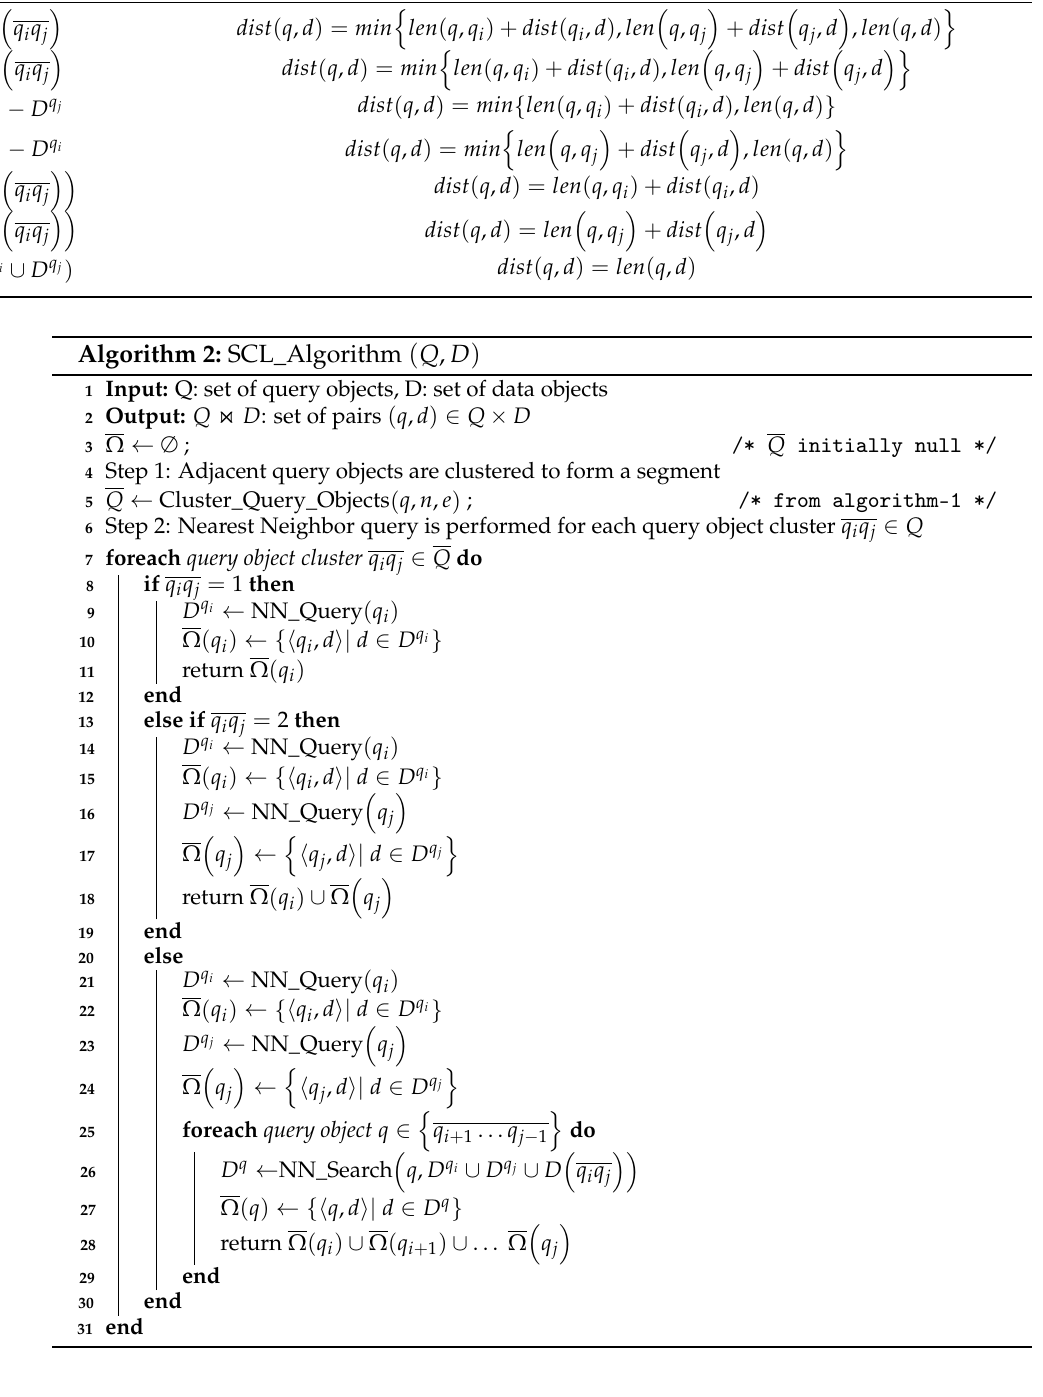
Table 2. Evaluation of dist ( q , d ) for q ∈ q i q j and d ∈ D q i ∪ D q j ∪ D Condition